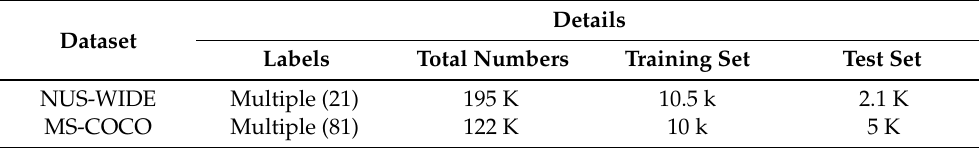
Table 1. Datasets composition and partition